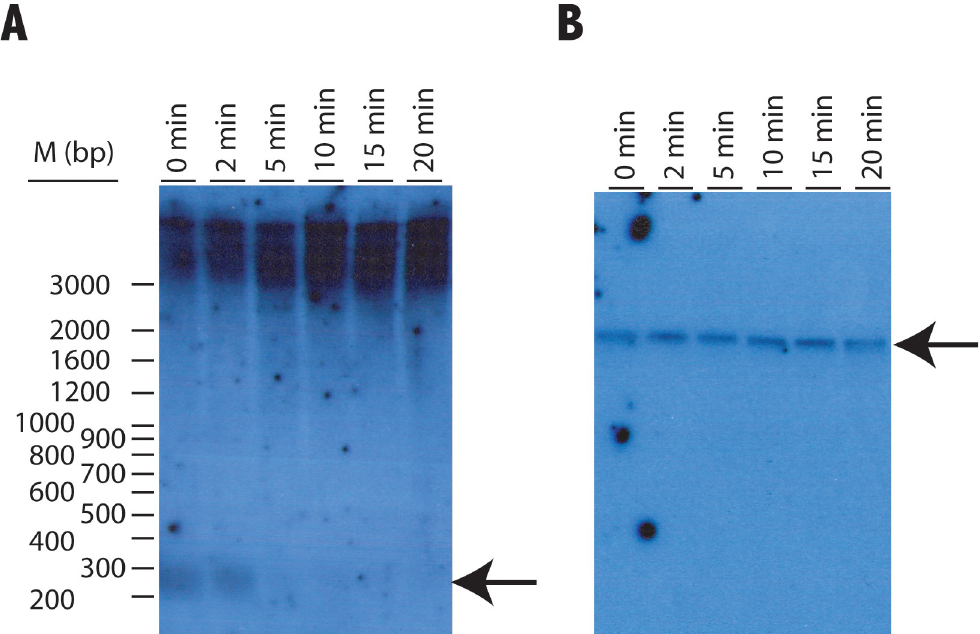
Fig 4. Southern blot analyses of Bal 31 sensitivity. Total DNA was isolated from AX4 cells and incubated with one unit of Bal31 exonuclease at 30˚C for the periods of time indicated in the upper part of each lane. After this incubation, Bal31 exonuclease was inactivated and the DNA digested with the NheI restriction enzyme. Digested DNAs were blotted and hybridized to a oligonucleotide probe complementary to the A(G)n repeats (panel A) or a probe complementary to a region of the 26S rRNA coding gene (panel B). The migration of the Ladder VII molecular weight marker (Nzytech, Lisbon, Portugal) is shown to the left (M(bp) lane). Specific hybridizing bands are indicated by arrows in panels A and